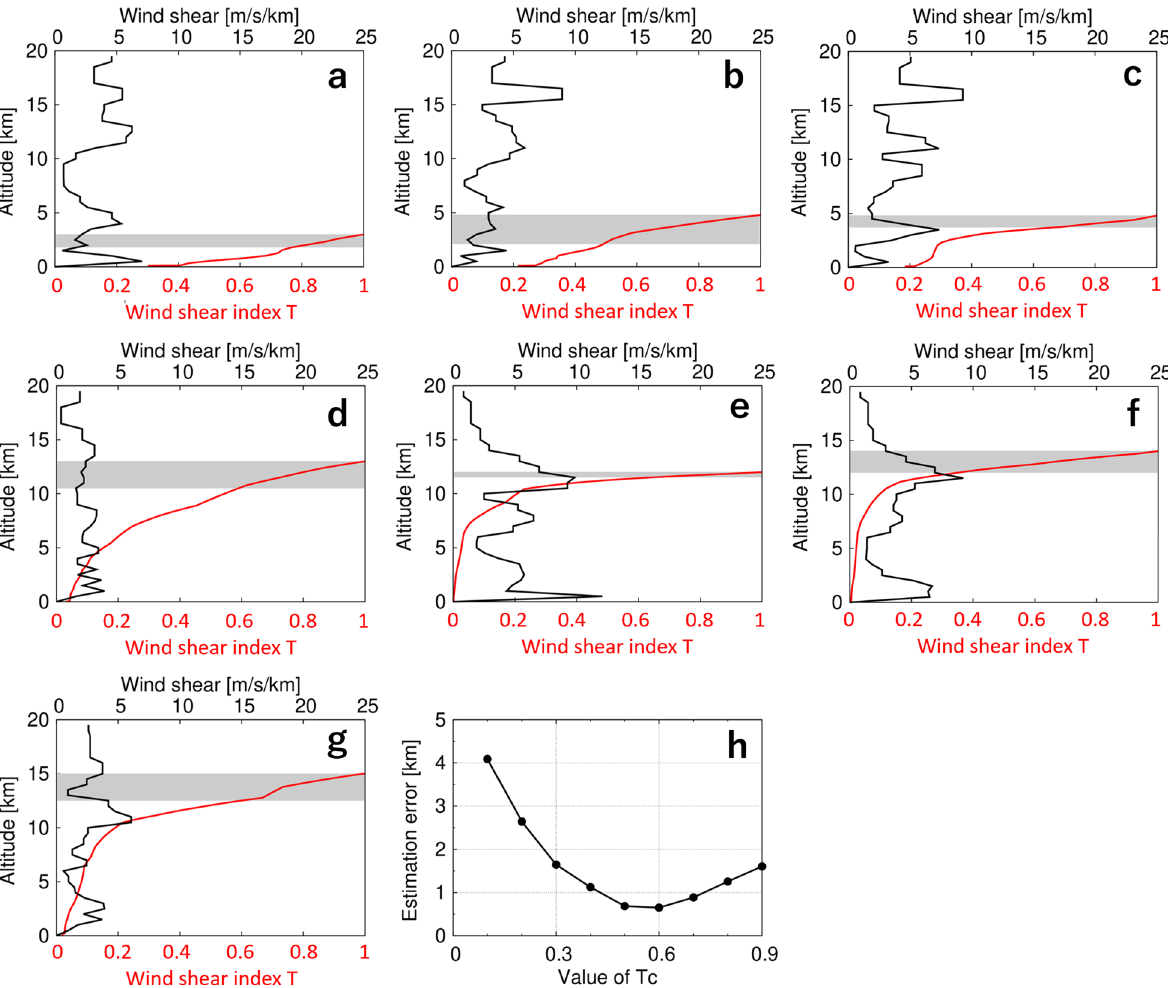
Fig. 4 Wind shear index T (red line), the observed ash clouds layers by lidar (grey), and the wind shear strength | d v / dz | (black line). a The case for 40.838N/14.183E on July 26, 2001. b The case for 40.333N/18.1E on July 26, 2001. c The case for 40.6N/15.72E on July 25, 2001. d The case for 41.76S/168.15E on June 23, 2011. e The case for 58.0N/68.56W on August 15, 2008. f The case for 56.19N/69.59W on August 15, 2008. g The case for 48.11N/178.64E on June 25, 2009. The cases of a - c , d , e - f and g are for the Mt. Etna eruption in Italy (Wang et al. 2008), the Mt. Cordon eruption in Chile (NASA 2016), the Mt. Kasatochi in Alaska (Prata et al. 2017), and the Mt. Sarychev in Russian (Prata et al. 2017), respectively. h The relationship between the standard deviation (i.e., estimation error) and the empirical parameter T